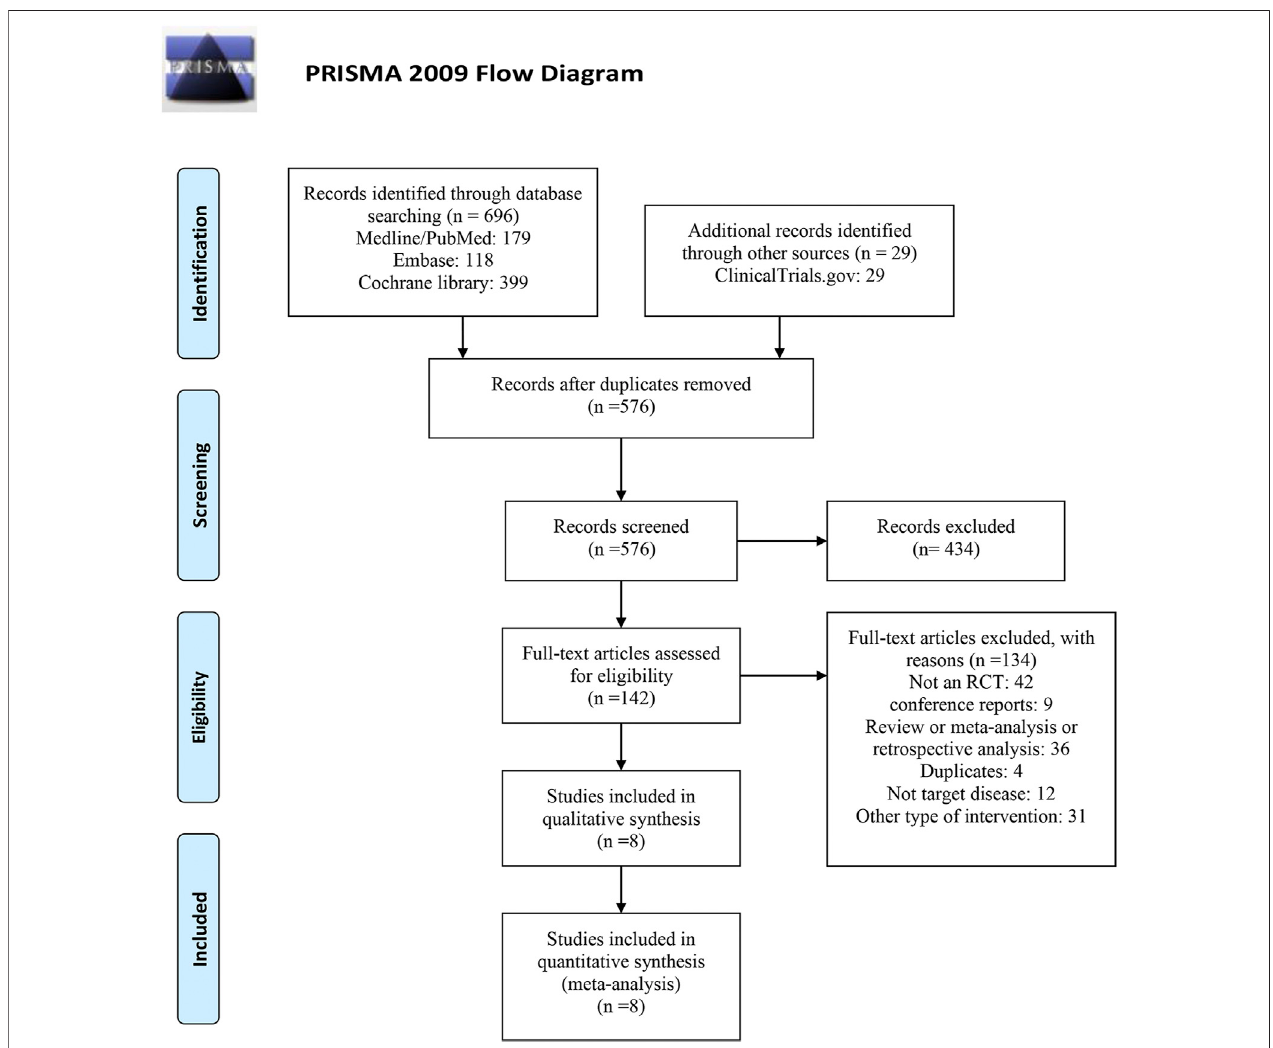
FIGURE 1 | PRISMA fl ow diagram for study